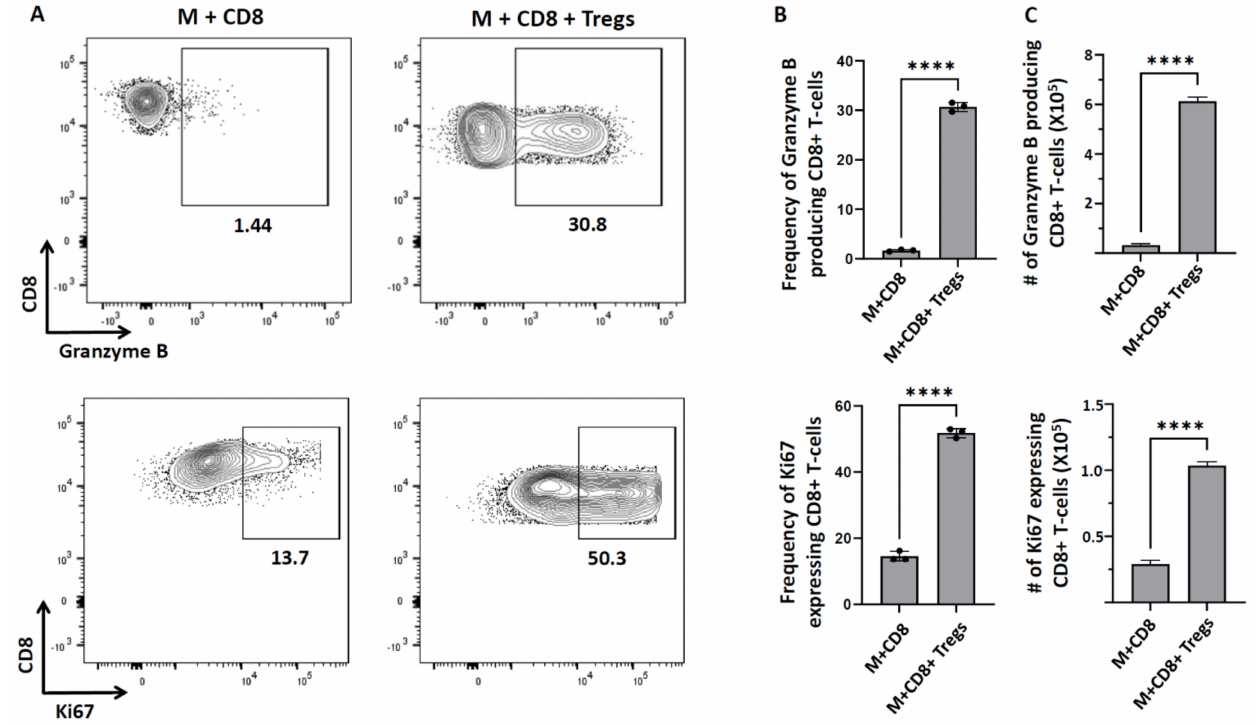
Figure 3. Tregs augment granzyme B production and T − lymphocyte proliferation. CD8 + T − cells were analyzed for the production of granzyme B and Ki67 after 18 h of co-culture with microglia in the presence or absence of Tregs. ( A ) Representative contour plots show expression of granzyme B and Ki67. ( B ) Bar graphs show the frequency of granzyme B − and Ki67 − producing CD8 + T − cells. ( C ) Bar graphs show the number of granzyme B − and Ki67 − producing CD8 + T − cells. Data shown are representative of three experiments using 3 wells/group/experiment and expressed as mean ± SE. rAd − OVA − primed OT − 1 mice ( n = 2/experiment) and IL − 2/anti − IL − 2-injected C57BL/6 mice ( n = 4/experiment). **** p < 0.0001.